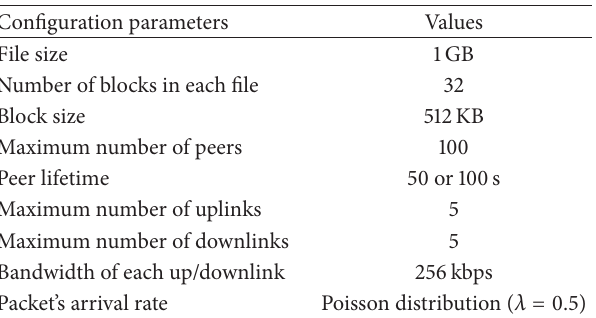
Table 1: Experimental